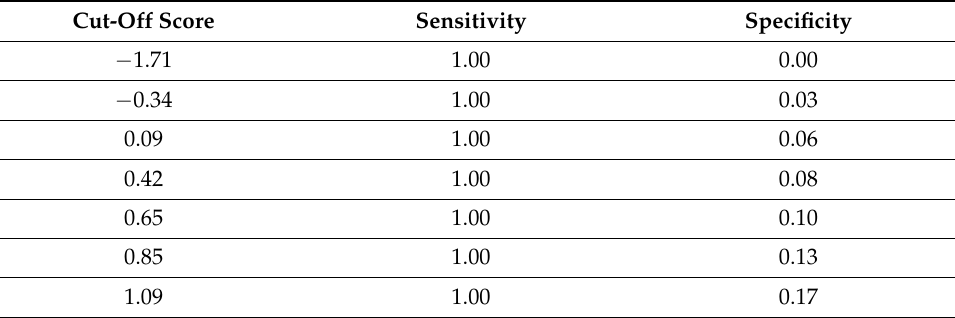
Table 5. Cut-off scores and corresponding sensitivity and specificity analyses of the newly developed frailty assessment